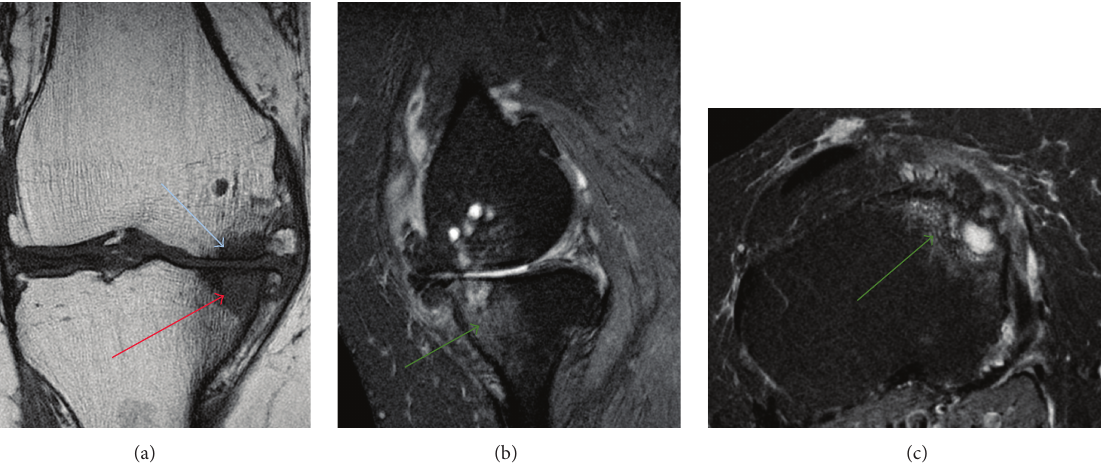
Figure 3: (a) Coronal T1 MRI with contrast image in painful knee OA patient showing large medial proximal tibial BML (red arrow) and smaller medial distal femoral BML (blue arrow). (b) Corresponding proton density weighted fat suppressed sagittal MRI sequence showing the large anteromedial BML (green arrow). (c) Axial proton density weighted fat suppressed MRI showing the tibia BML.